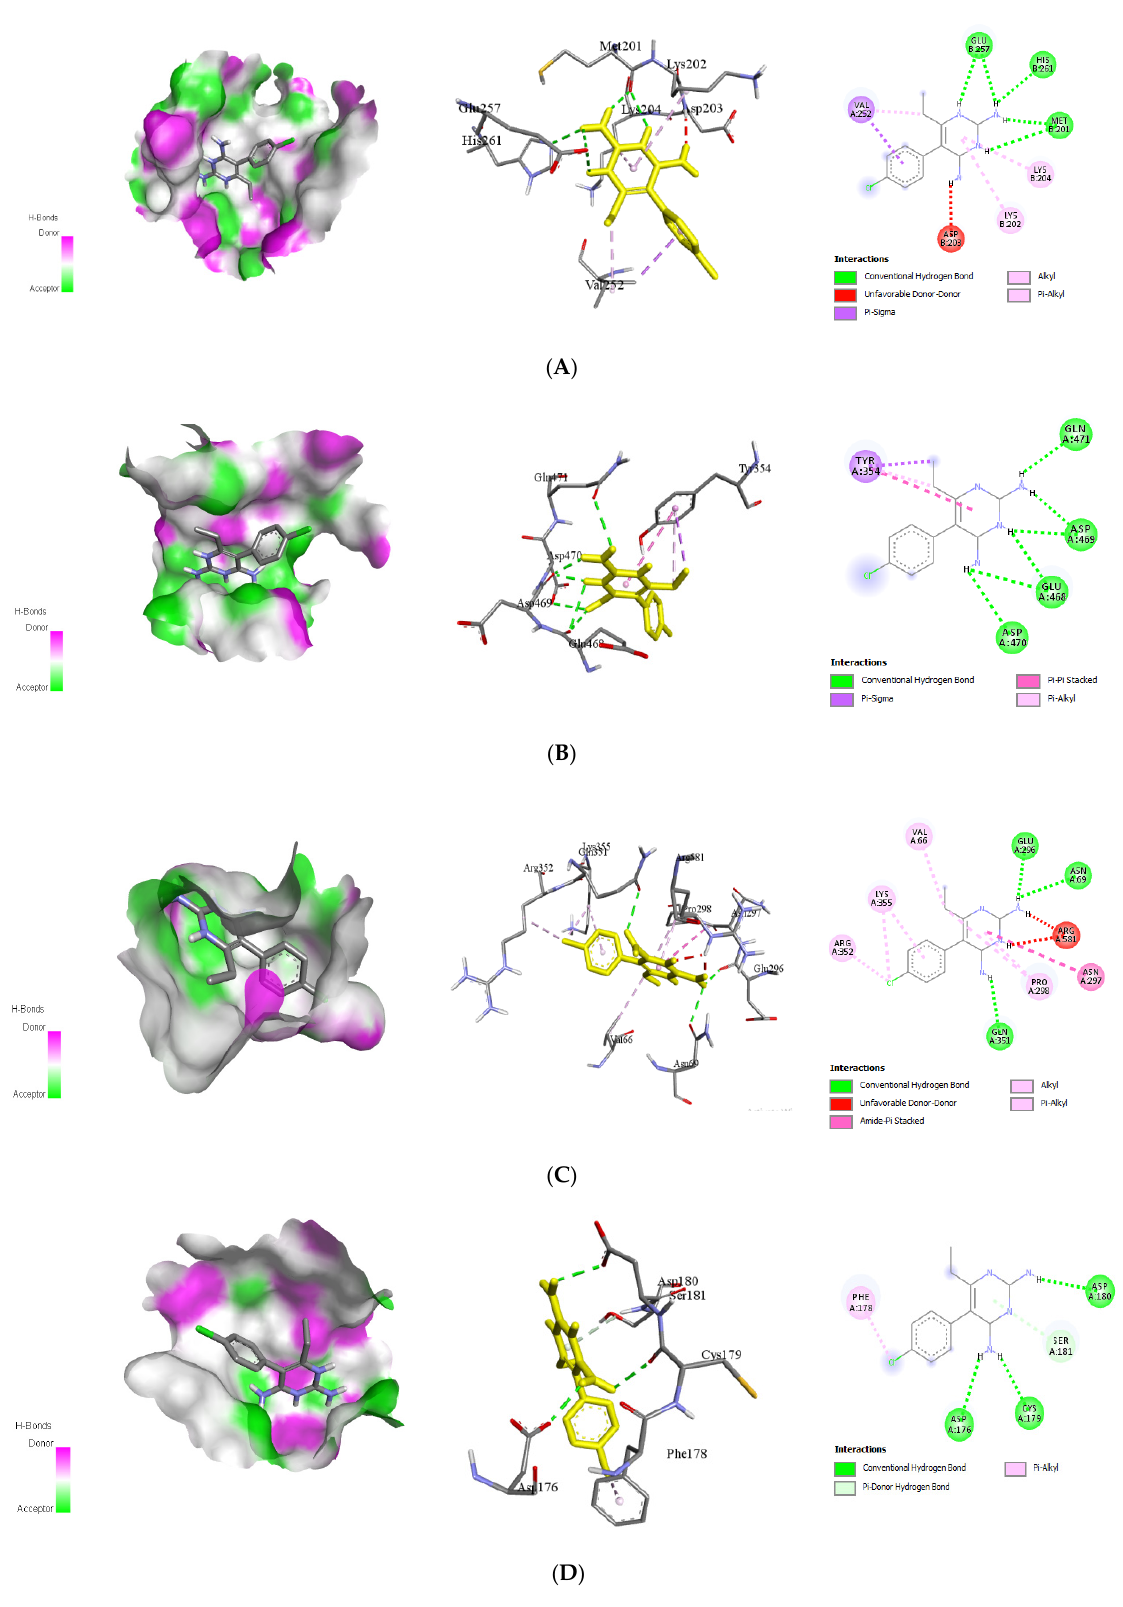
Figure 7. Interaction of reference drugs (pyrimethamine; IUPAC name: 5-(4-chlorophenyl)-6-ethylpyrimidine-2,4-diamine-chloridine) with dengue virus protein. ( A ) Envelope (E) protein (PDB ID: 1OKE); ( B ) NS3 (PDB ID: 2VBC); ( C ) NS5 (PDB ID: 4V0Q); ( D ) NS1 (PDB ID: 4O6B).